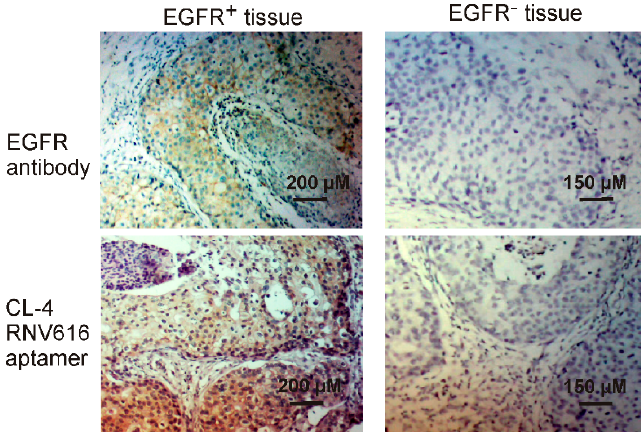
Figure 8. Tissue immunostaining of both EGFR positive and negative breast cancer by CL-4RNV616 aptamer and EGFR antibody. H&E stain was conducted for morphological confirmation.